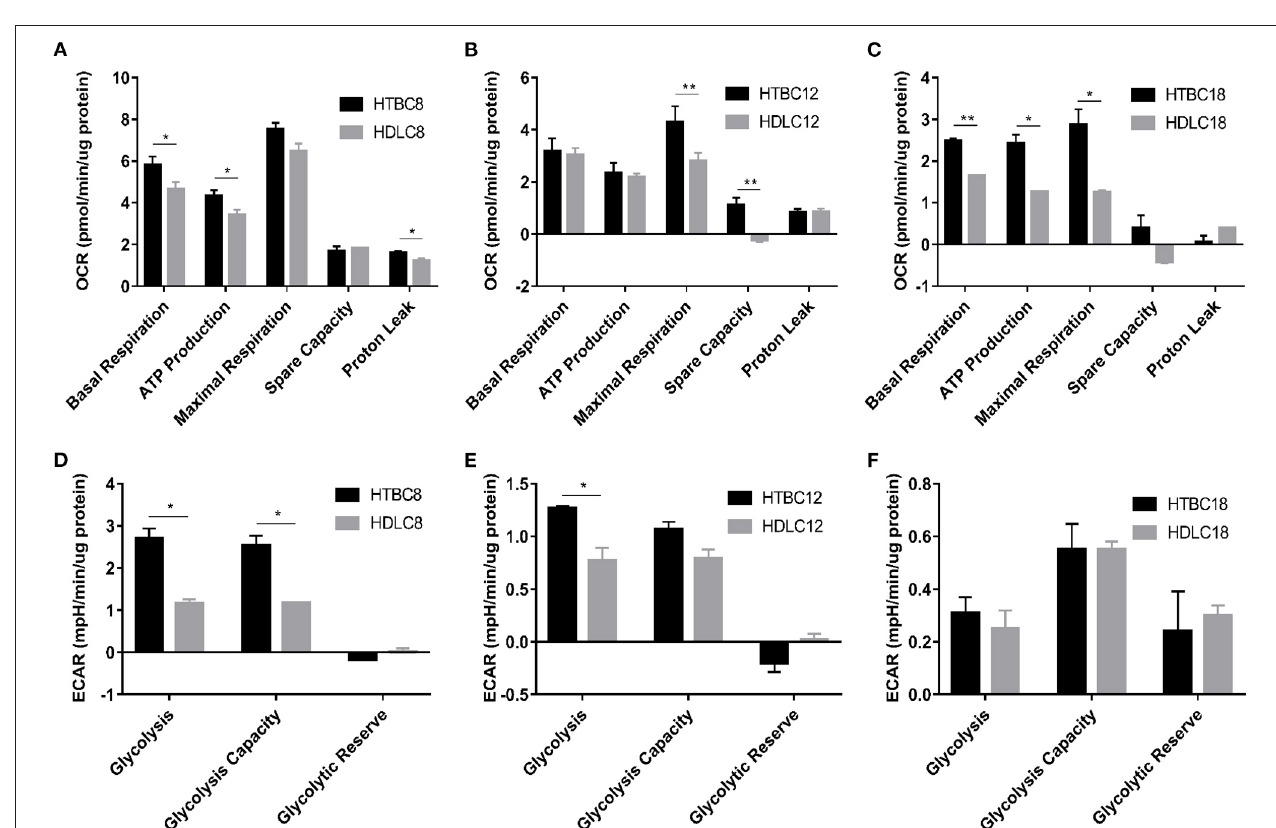
FIGURE 4 | The OCR and ECAR results under hypoxia at different embryo developmental stages of chicken. (A–C) The OCR of chicken primary brain cells on days 8, 12, and 18 of incubation under hypoxia ( n = 3). (D–F) The ECAR of chicken primary brain cells on days 8, 12, and 18 of incubation under hypoxia ( n = 3). HTBC, TBCs under hypoxia; HDLC, DLCs under hypoxia. Data are indicated as the mean ± SEM. Asterisks represent significance TBCs compared to DLCs. * P < 0.05, ** P < 0.01.